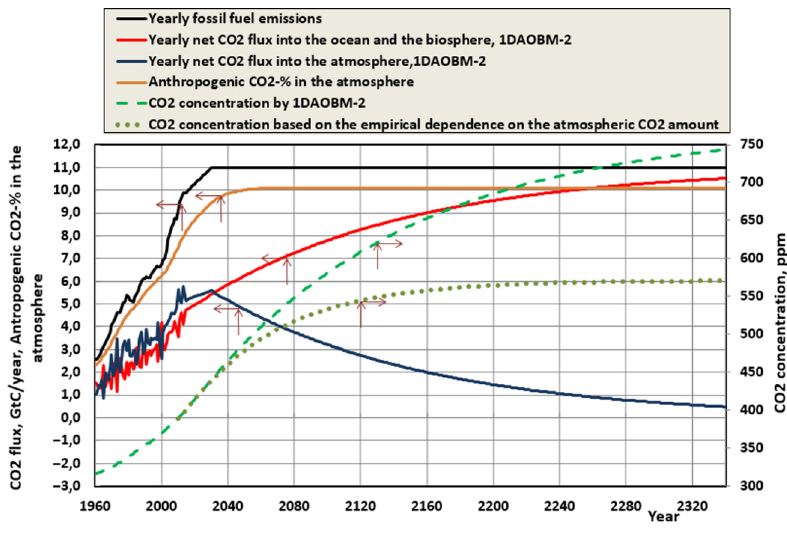
Figure 4. The future projections of CO 2 fl uxes and the CO